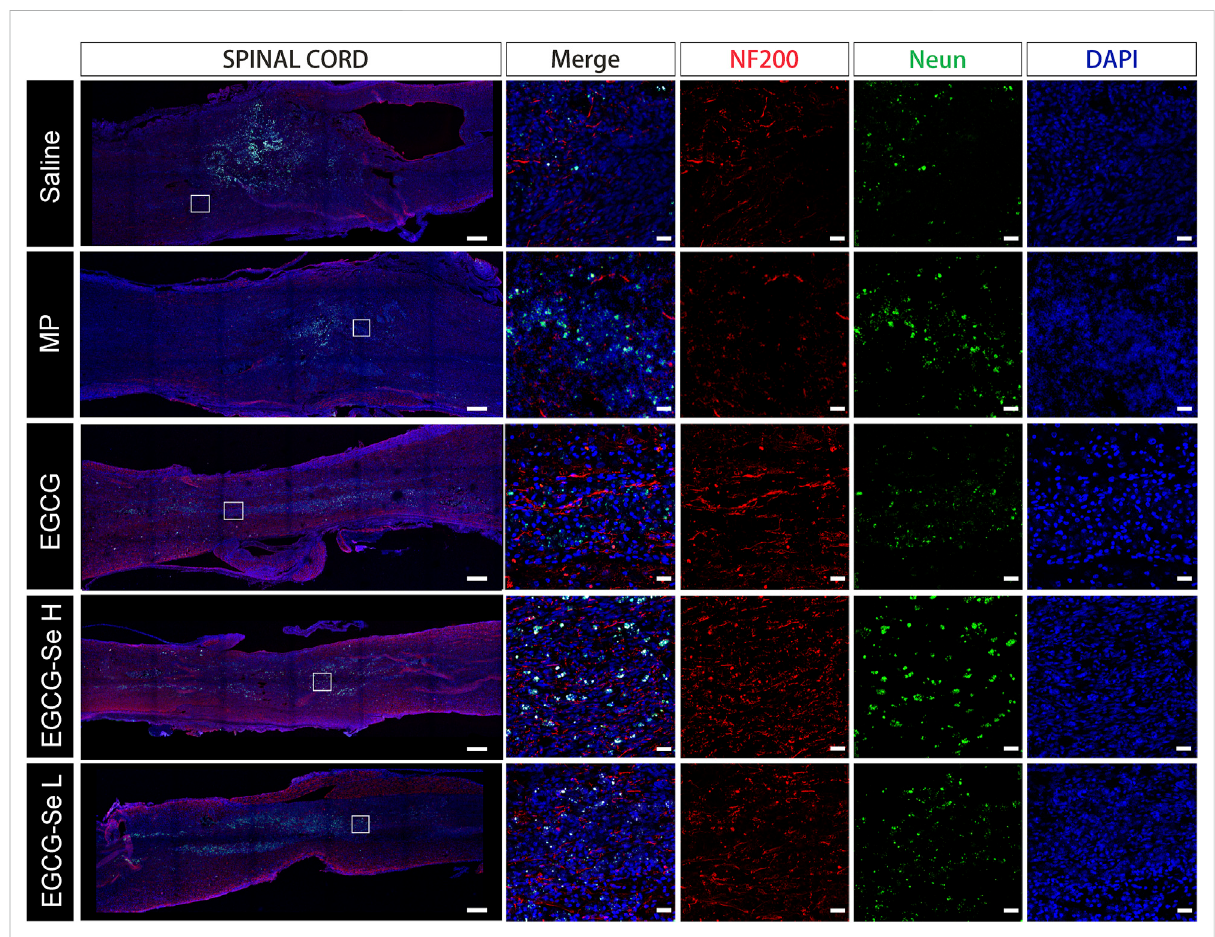
FIGURE 6 Anti-NF200 and anti-NeuN double-staining of different groups at 8 weeks post-injury. Scale bars are 400 μ m in the fi rst column and 25 μ m in the other columns. MP, methylprednisolone; EGCG, epigallocatechin-3-gallate; L, 5 mg/kg EGCG-Se nanoparticles; H, 10 mg/kg EGCG-Se